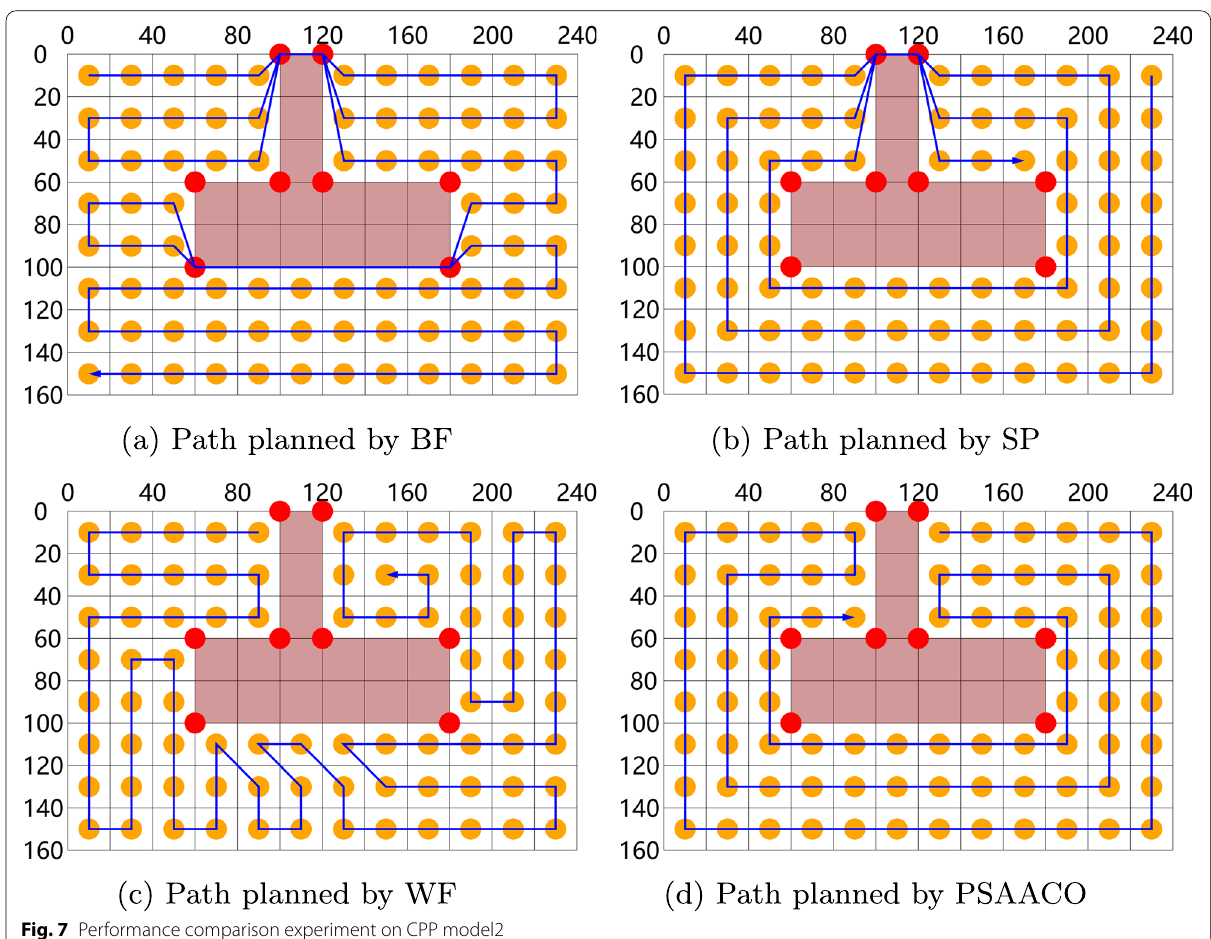
Fig. 7 Performance comparison experiment on CPP